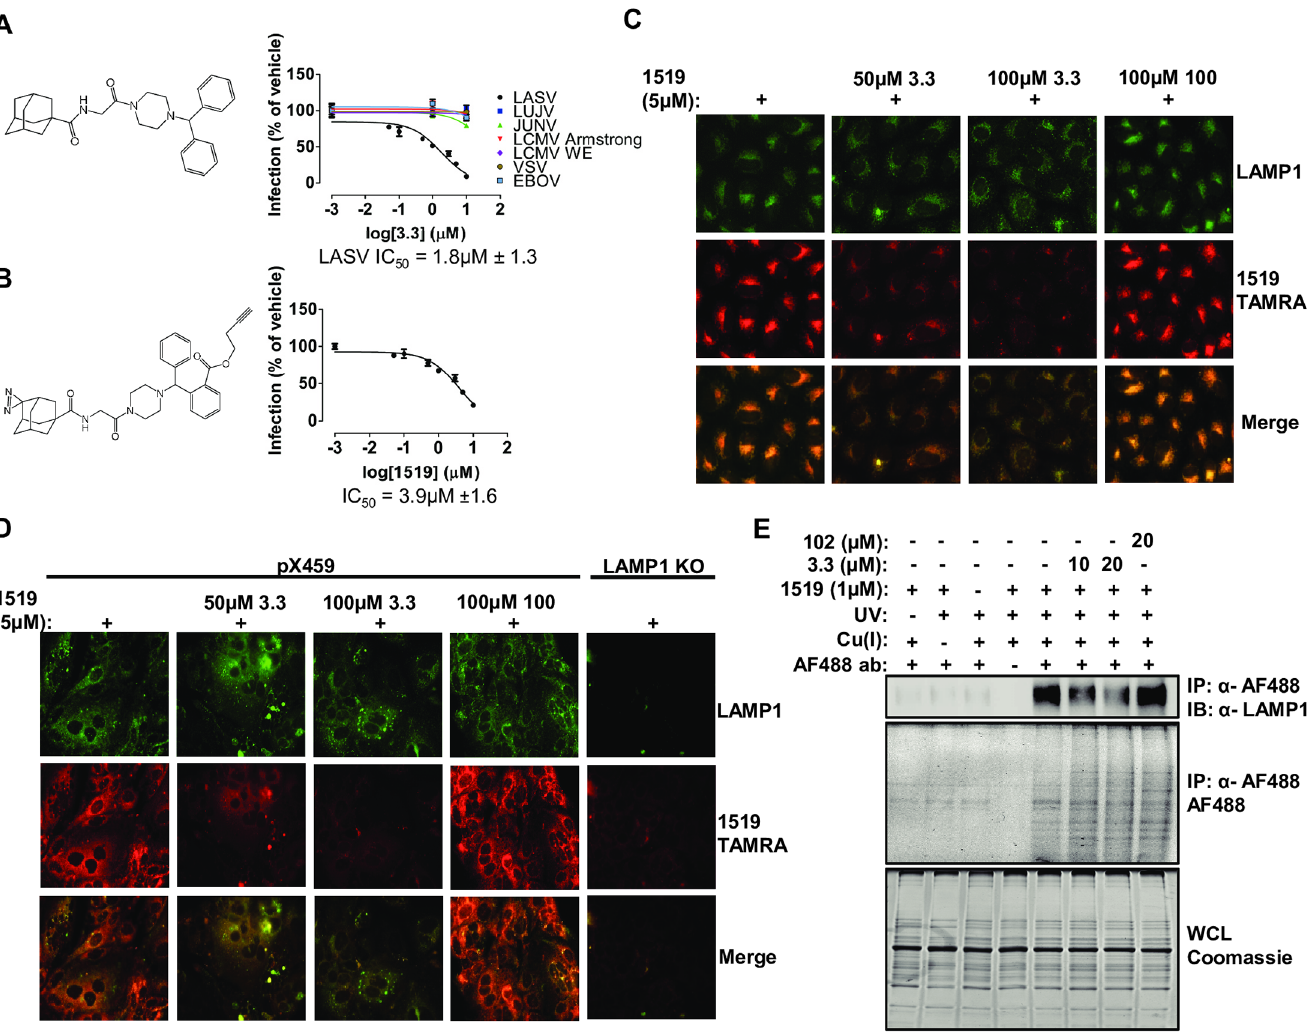
Fig 1. 3.3 inhibits LASV GP-mediated infection and cross-links to the LASV receptor, LAMP1, in cells. (A) Structure of 3.3 (left) and inhibition of transduction by MLV pseudotyped with the indicated viral glycoproteins (right). Vero cells were incubated with the indicated concentrations of 3.3 for 1h before challenge with MLV encoding GFP and pseudotyped with the indicated viral glycoproteins. Virus transduction is reported as % of GFP-positive cells relative to cells exposed to DMSO vehicle alone. Data are mean ± SD ( n = 3). IC 50 is the concentration of inhibitor required to reduce transduction by 50%. LUJV: Lujo virus; JUNV: Junin virus; LCMV: Lymphocytic choriomeningitis virus; VSV: Vesicular stomatitis virus; EBOV: Ebola virus. (B) Structure of 1519 (left). 1519 contains a diazirine for target cross-linking and a terminal alkyne for Cu + -catalyzed click-based analysis and inhibits transduction by MLV pseudotyped with LASV GP (right). Vero cells were incubated with the indicated concentrations of 1519 for 1h before challenge with MLV pseudotyped with LASV GP and encoding GFP. Virus transduction is reported as % of GFP- positive cells relative to cells exposed to DMSO vehicle alone. Data are mean ± SD ( n = 3). Data was collected in the same experiment as Fig 1A. (C) 1519 co-localizes with LAMP1+ compartments in Vero cells and cross-links in a manner which is competed by the addition of a molar excess of 3.3 but not the inactive 3.3 derivative, 100. Vero cells were co-incubated with 1519 and the indicated competitor compound for 1h at 37˚C before UV irradiation followed by click chemistry with TAMRA azide. LAMP1 was visualized by immunofluorescence using an anti-LAMP1 antibody. (D) 1519 co-localizes with LAMP1+ compartments in Huh7.5 cells and cross- links in a manner which is competed by the addition of a molar excess of 3.3 but not the inactive 3.3 derivative, 100. 1519 cross-linking in Huh7.5 LAMP1 knockout (KO) cells is diminished. Huh7.5 pX459 or LAMP1 KO cells were co-incubated with the indicated compounds for 1h at 37˚C before UV irradiation followed by click chemistry with TAMRA azide. LAMP1 was visualized by immunofluorescence using an anti-LAMP1 antibody. (E) 1519 cross-links to endogenous LAMP1 in a manner which is competed by the addition of a molar excess of 3.3 but not the inactive 3.3 derivative, 102. Vero cells were incubated with the indicated compounds for 1h at 37˚C before UV irradiation. Cells were harvested, lysed and used for click chemistry to attach an Alexa Fluor 488 (AF 488) azide and then subjected to immunoprecipitation using an anti-AF 488 antibody. AF 488 labeled LAMP1 was detected using an anti-LAMP1 antibody. Total AF 488 labeled proteins were detected via in-gel fluorescence. Input protein was detected by Coomassie staining.